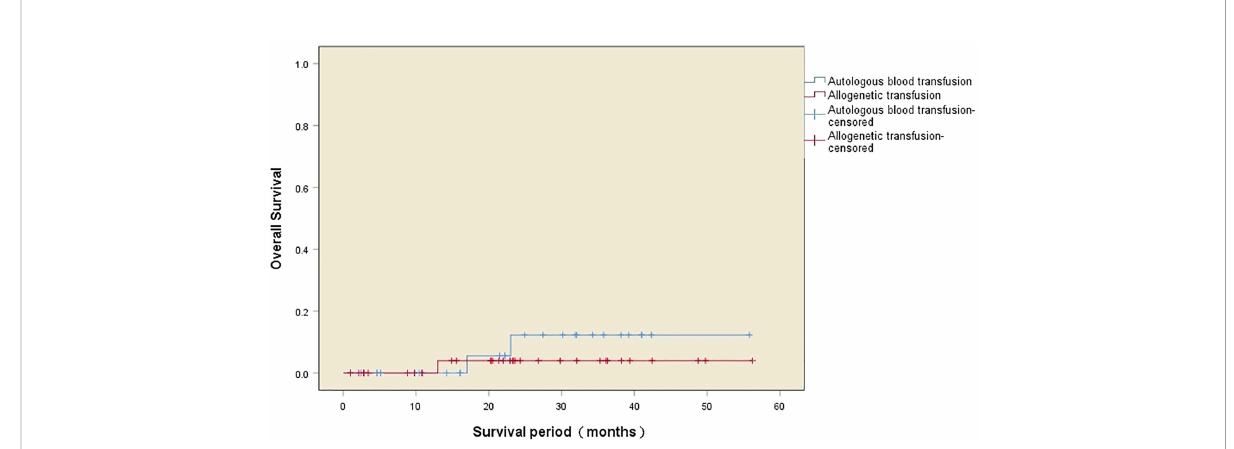
FIGURE 1 Kaplan – Meier curves of the cumulative tumor recurrence rate after the operation in the two